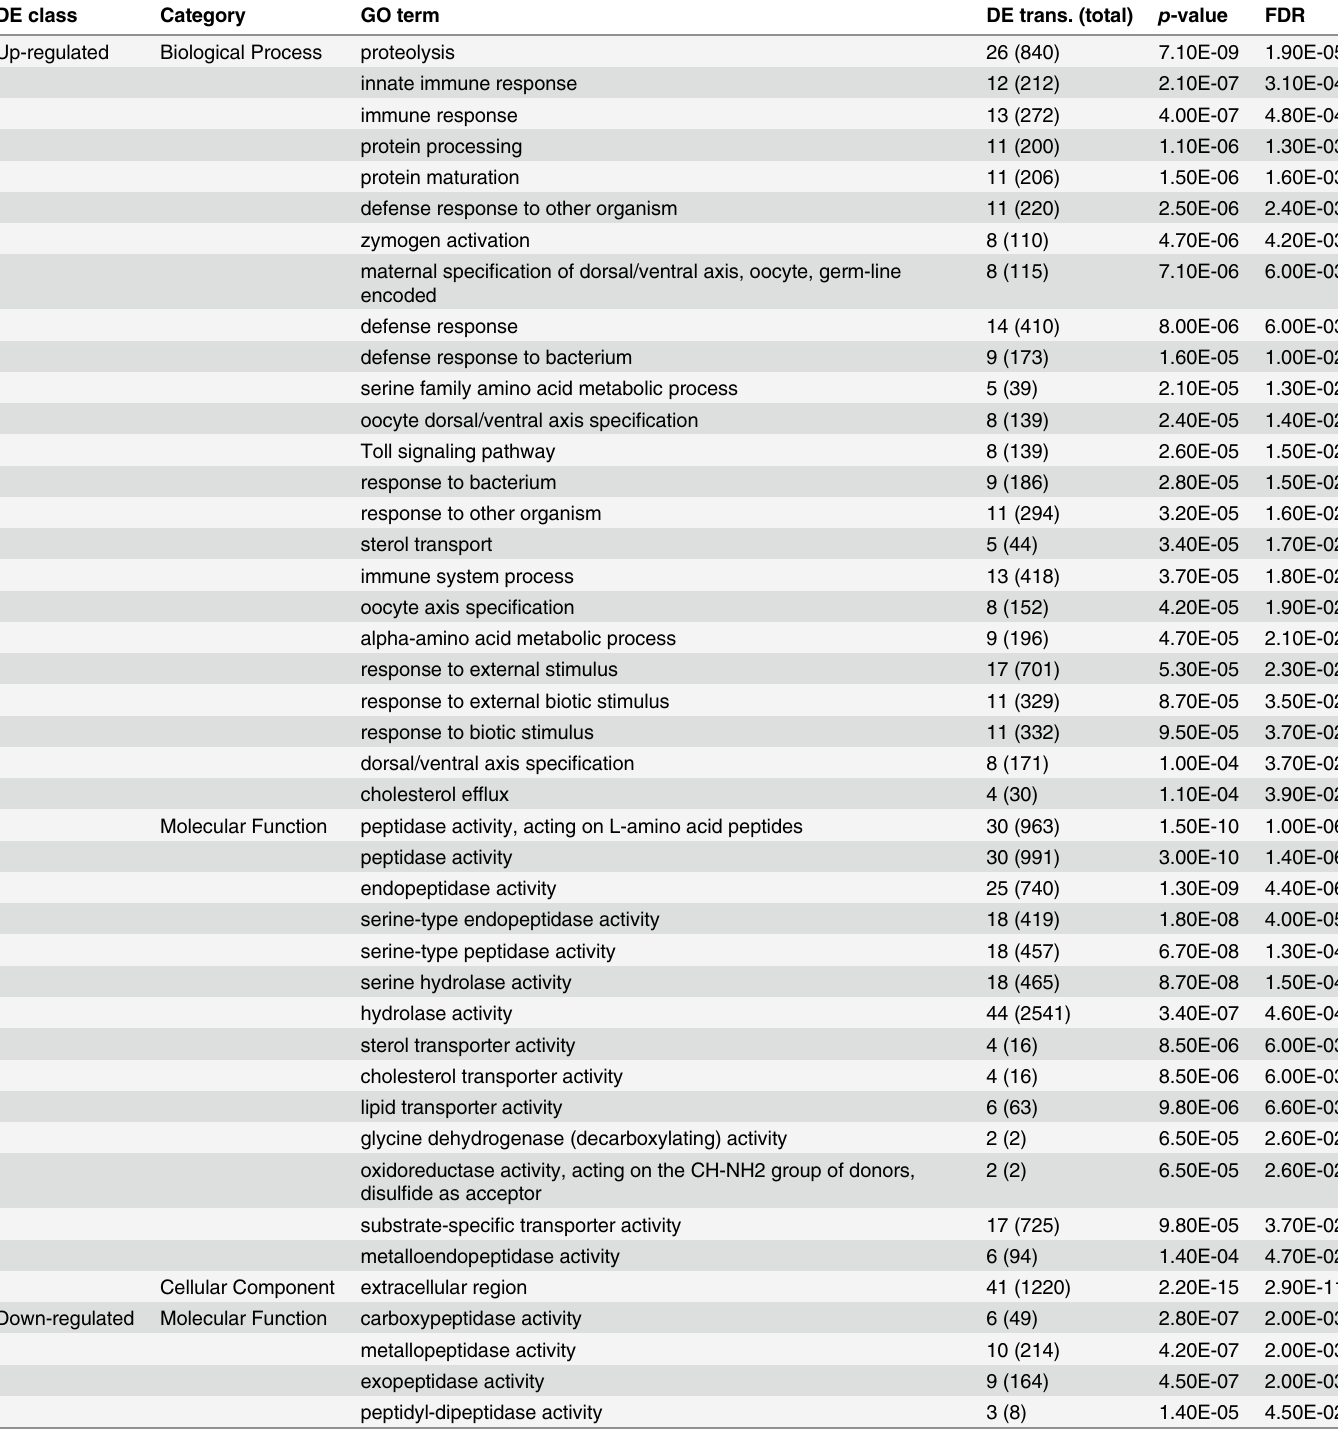
Table 1. Gene ontology (GO) enrichment analysis for up- and down-regulated